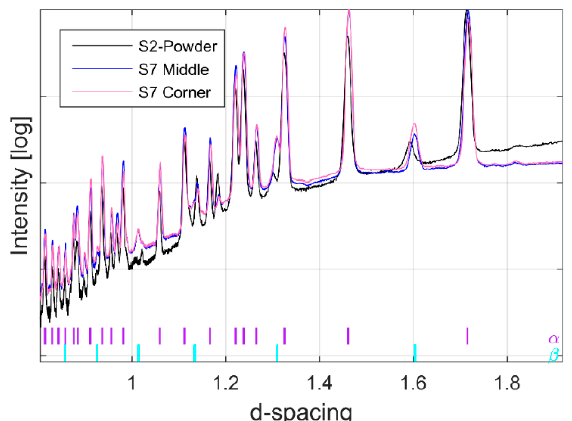
Figure 3. Diffraction pattern obtained by EDXRD of Ti-6Al-4V powder and EBM built material. The colour coded, small vertical tick marks represent the hkl peak positions of labelled phases in the same colour ( α = purple, β = magenta).